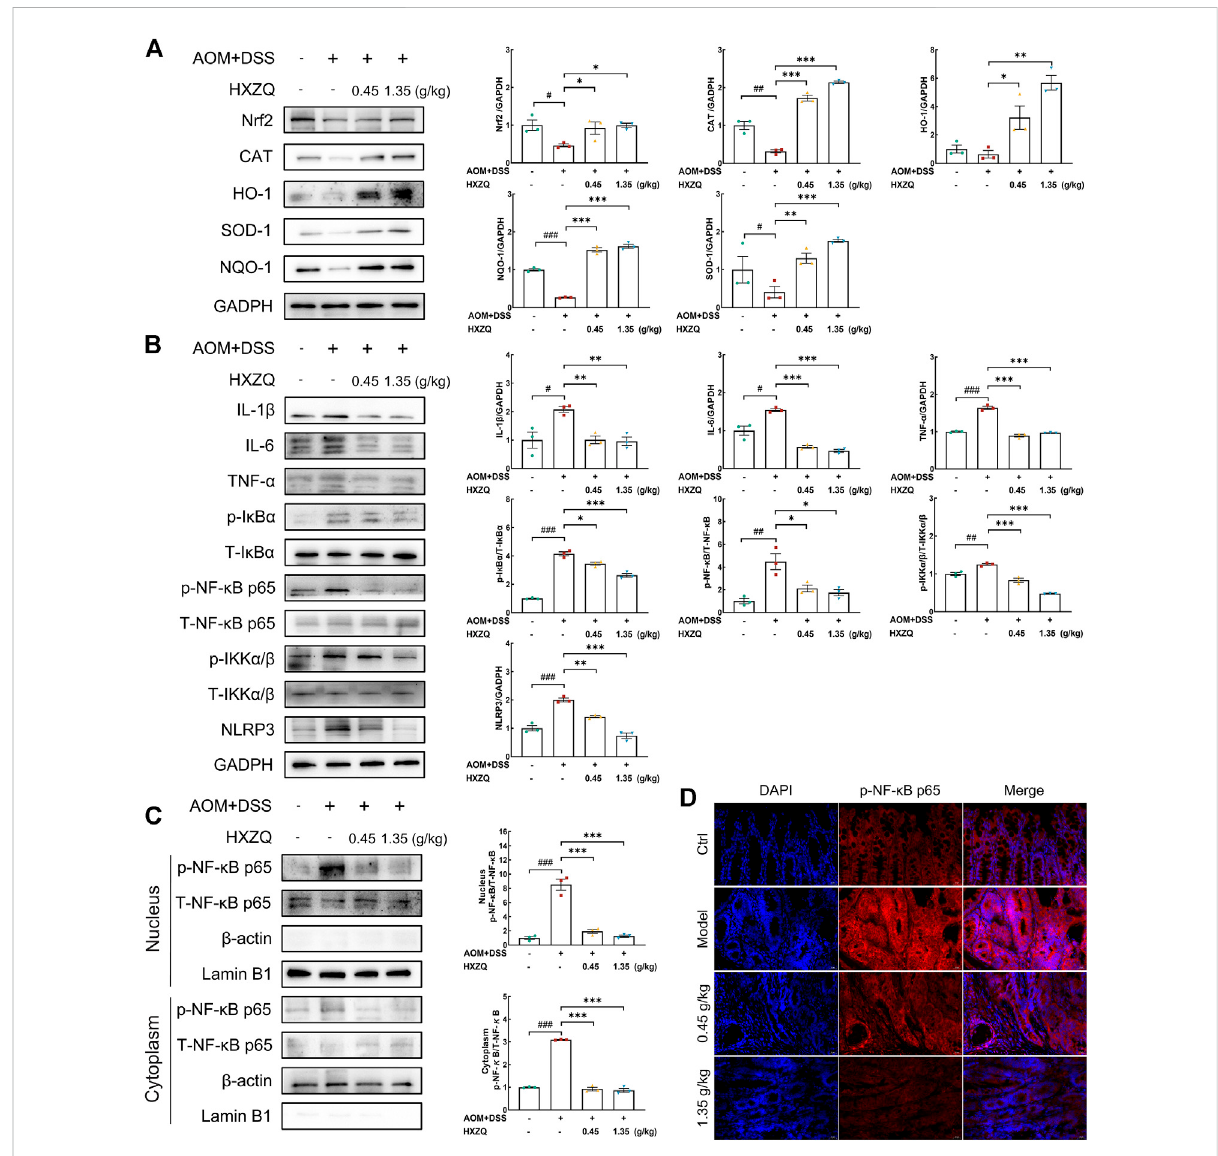
FIGURE 5 HXZQ regulated the expression of proteins in the colorectal tumors of AOM/DSS mice. (A) Proteins associated with oxidative stress, including Nrf2, CAT, HO-1, SOD-1, and NQO-1. (B) Proteins associated with in fl ammation, including IL-1 β , IL-6, TNF- α , p/T-I κ B α , p/T-NF- κ B, p/T-IKK α / β , and NLRP3. (C) HXZQ decreased the phosphorylation level of NF- κ B in the cytoplasm and inhibited its translocation from the cytoplasm to the nucleus. (D) Immuno fl uorescence for p-NF- κ B was performed on colon sections (400 × ). Quantitative data were normalized by GAPDH and their corresponding total proteins and reported as fold change with respect to the expression data from the corresponding Ctrl mice ( n = 3). Data are presented as the means ± S.E.M. and differences were compared between Ctrl and Model using Student ’ s t-test. Comparisons between Model, 0.45 g/kgHXZQ, and1.35 g/kg HXZQ wereperformed with one-way ANOVA followedbyaposthoc multiplecomparisons(Dunnett) test. # p < 0.05, ## p < 0.01, and ### p < 0.001 vs. Ctrl group; * p < 0.05, ** p < 0.01, and *** p < 0.001 vs. model